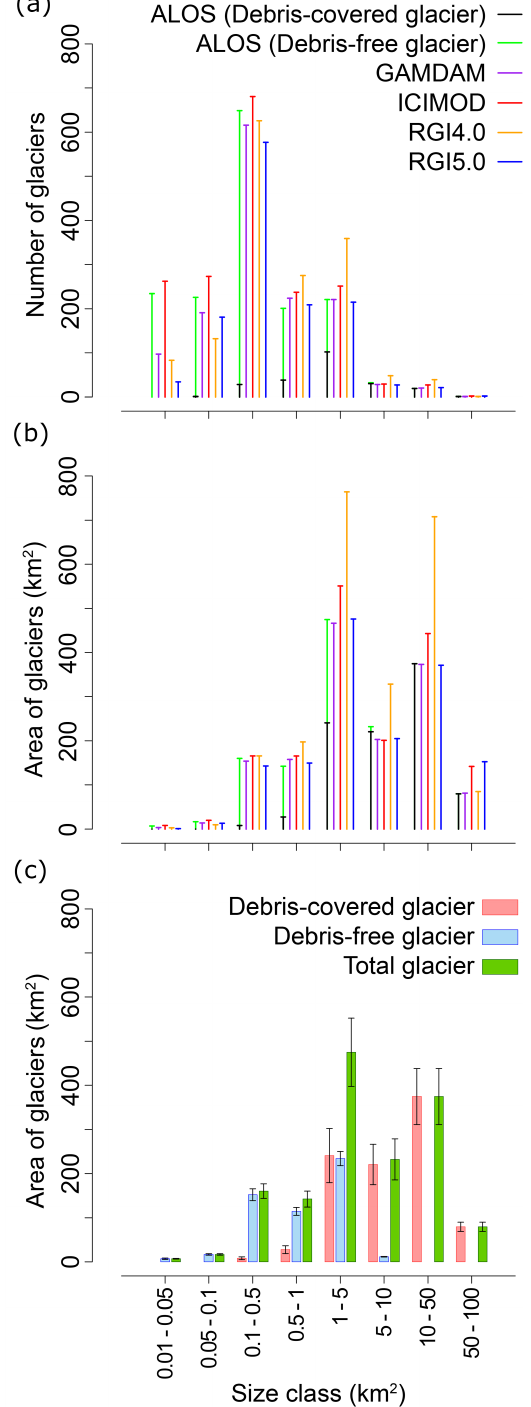
Figure 8. Cumulative glacier (a) number and (b) area values for eight size classes. (c) Estimated area of delineation uncertainty ratio is shown on debris-covered, debris-free, and total glaciers from the ALOS-derived glacier inventory.